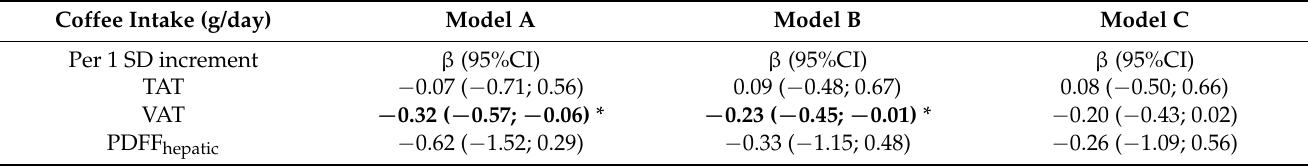
Table 3. Associations between coffee consumption and adiposity